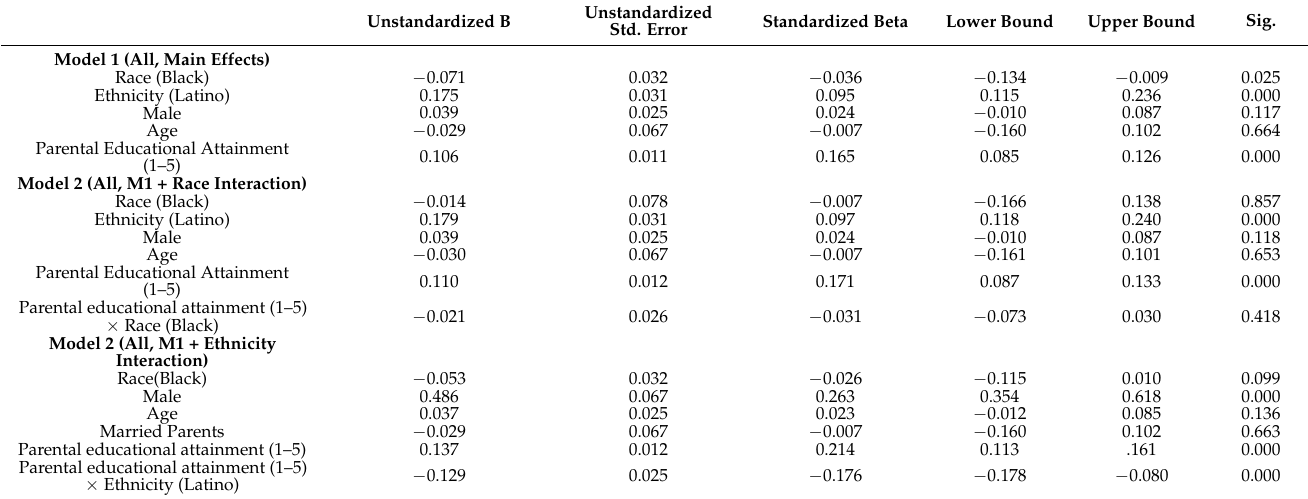
Table 2. Pooled Sample models in US